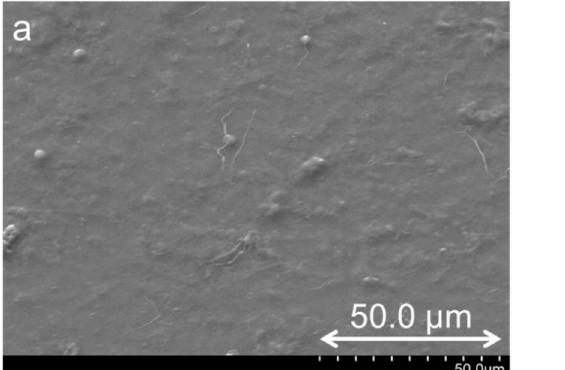
Figure A4. XRD patterns of laponite powder and PDDA-Laponite multilayers.